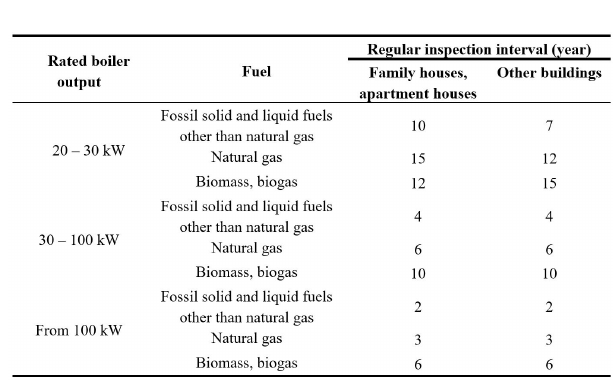
Table 4. Frequency of regular inspections of boilers in